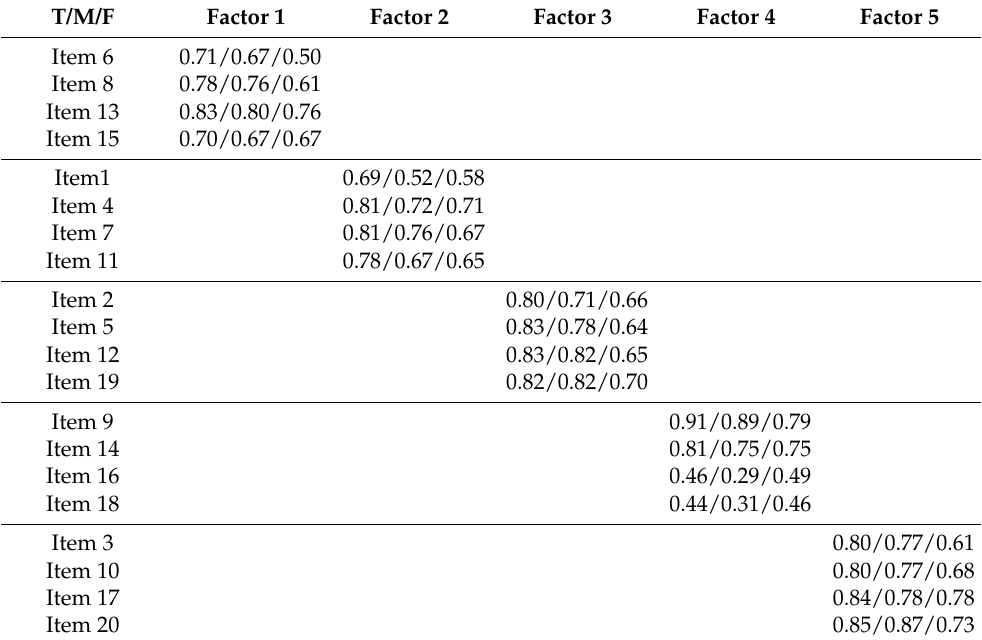
Table 2. Loadings for the five-factor structure of the